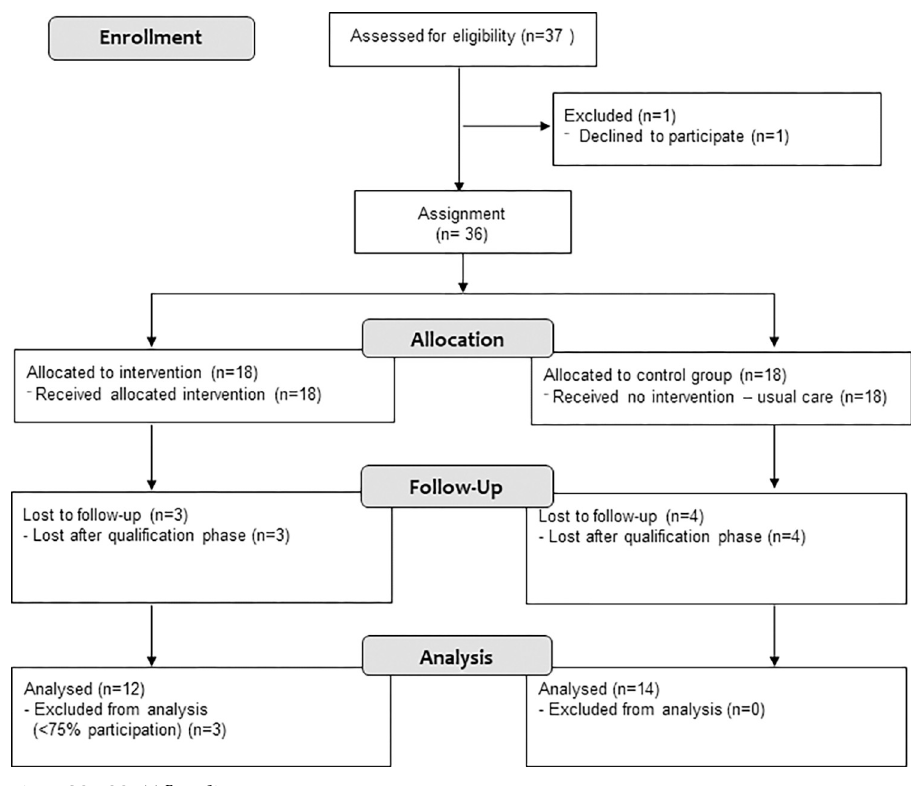
Fig 1. CONSORT flow diagram.